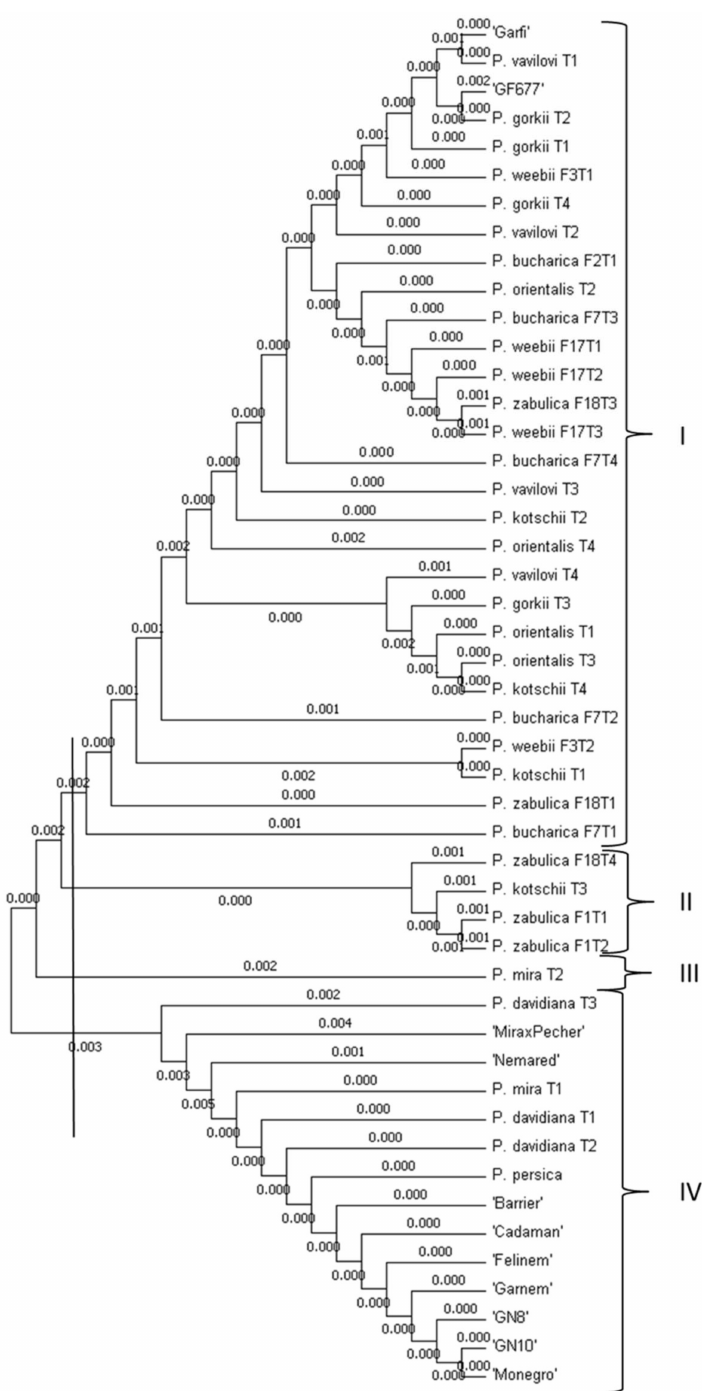
Figure 3. Dendrogram representing the phylogenetic differences in DREB2B promoter gene